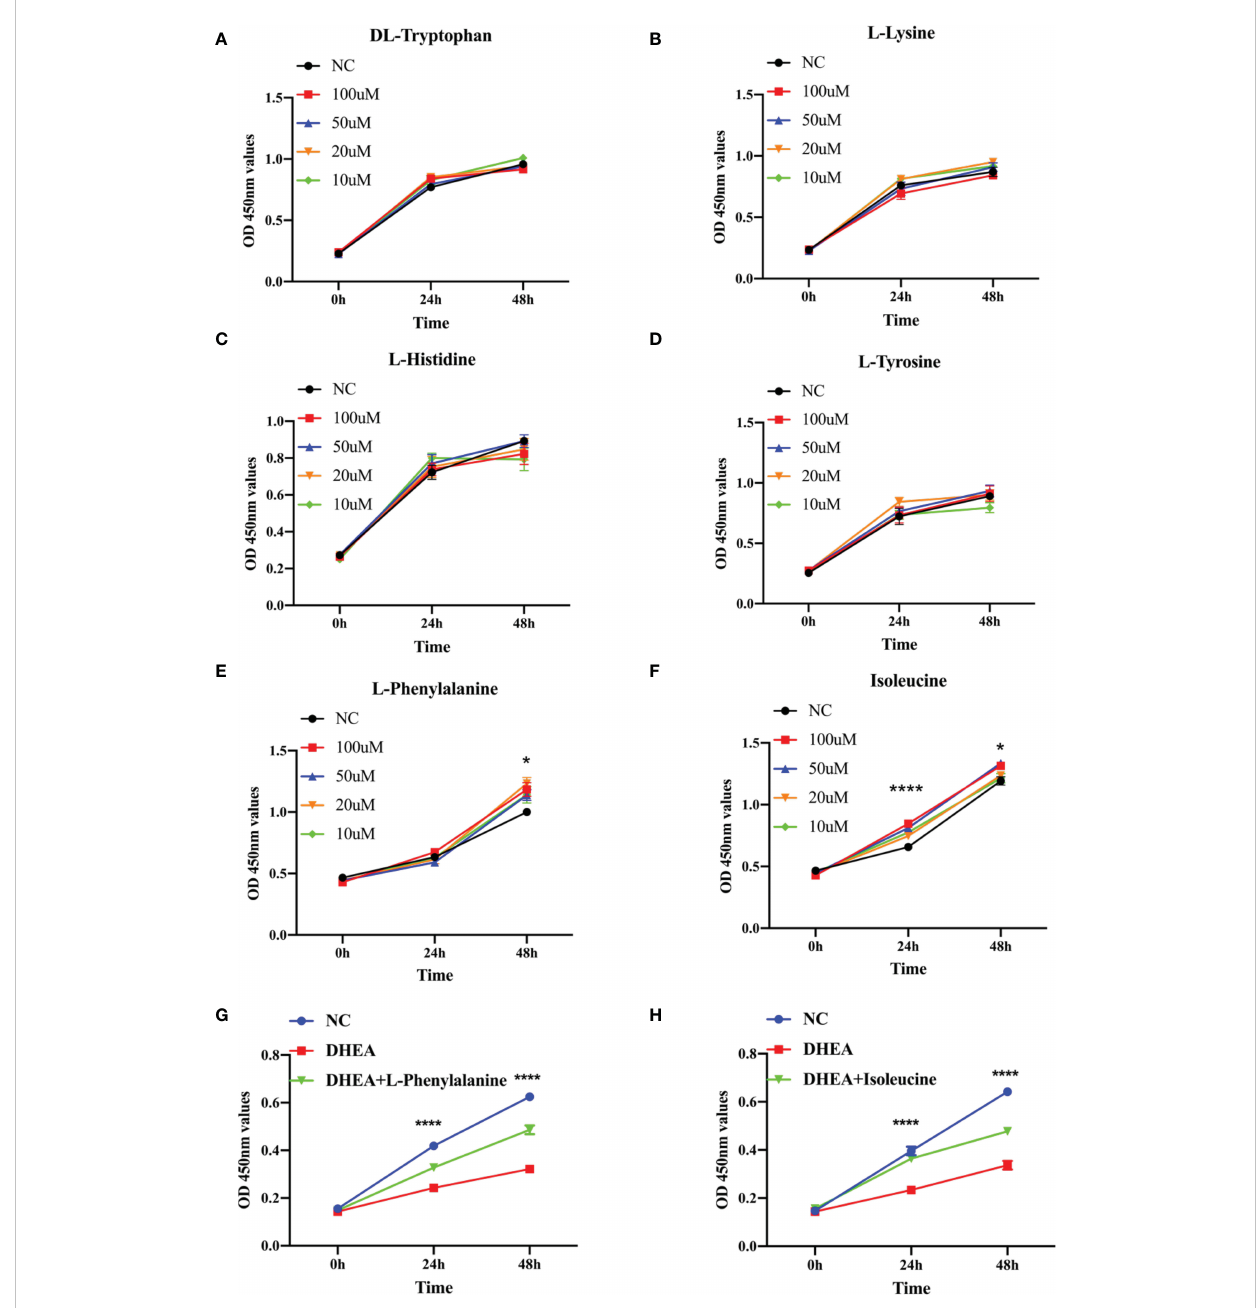
FIGURE 4 The growth function of representative metabolites in granulosa cells. (A – F) CCK-8 assays were used to detect cell viability of KGN cells at different times using the same concentration of metabolites (10, 20, 50, or 100 m M). (G) . Relative cell growth after treatment with DHEA (10 − 4 M) and L- phenylalanine (20 m M) was detected by the CCK-8 assay. (H) . Relative cell growth after treatment with DHEA (10 − 4 M) and isoleucine (20 m M) was detected by the CCK-8 assay. *p < 0.05, ****p <